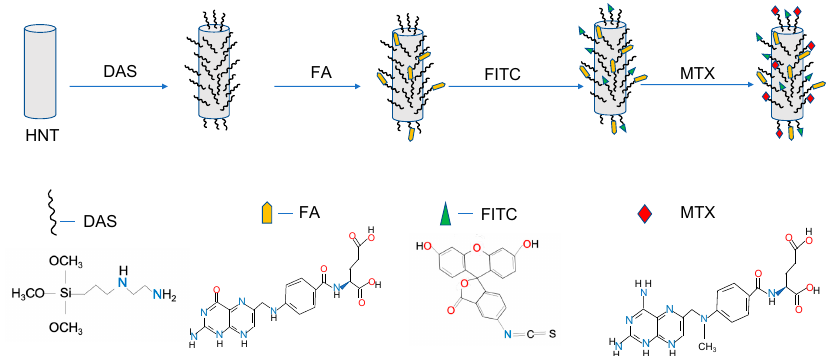
Figure 2. Schematic representation of the conjugation of both FA and FITC to DAS which is attached to the HNT surface. Methotrexate (MTX) was vacuum-doped into the HNT lumen. DAS = N -[3- (trimethoxysilyl)propyl) ethylenediamine, FA = folic acidity, FITC = fluorescein isothiocyanate.